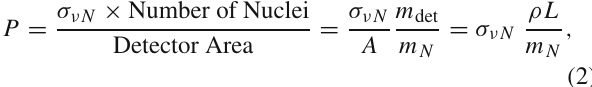
Fig. 4 The estimated number of neutrinos that pass through the 25 cm × 25 cm transverse area of FASER ν , assuming an integrated luminosity of 150 fb − 1 for Run 3 at the 14 TeV LHC. The event rates are for electron (left), muon (center), and tau (right) neutrinos (upper)